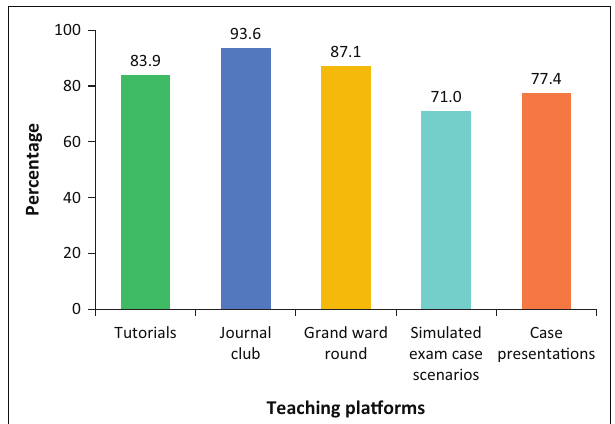
FIGURE 1: Teaching platforms at institutions.